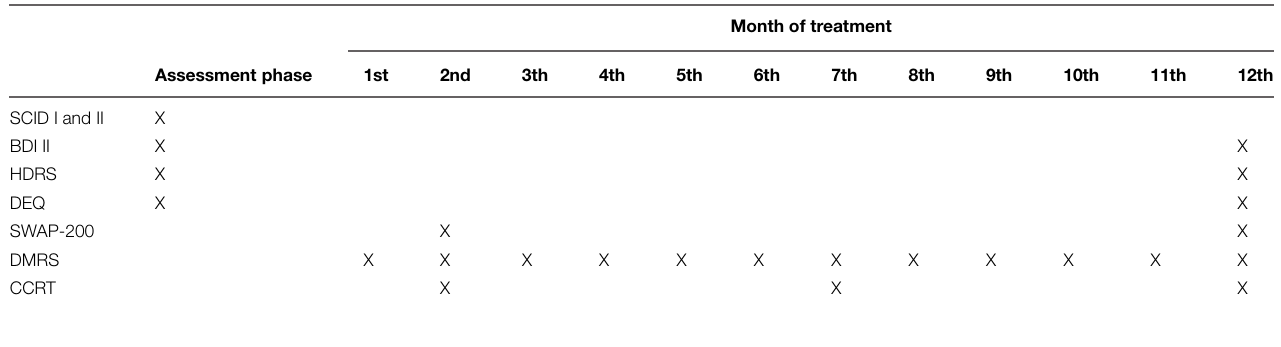
TABLE 1 | Research